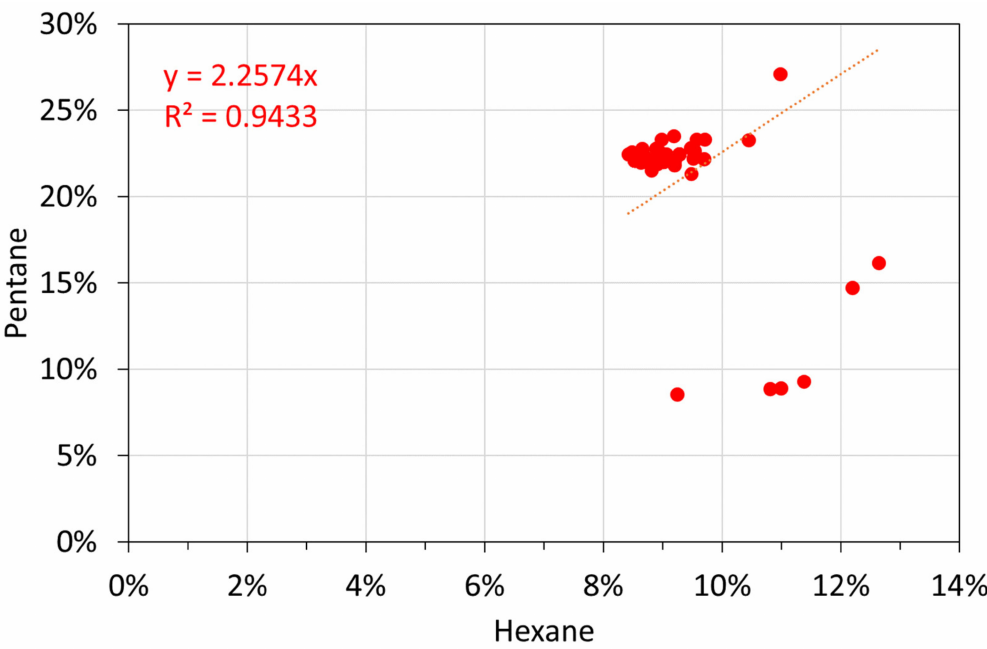
Figure A15. Molar alkane oil analyses: hexane vs. pentane.